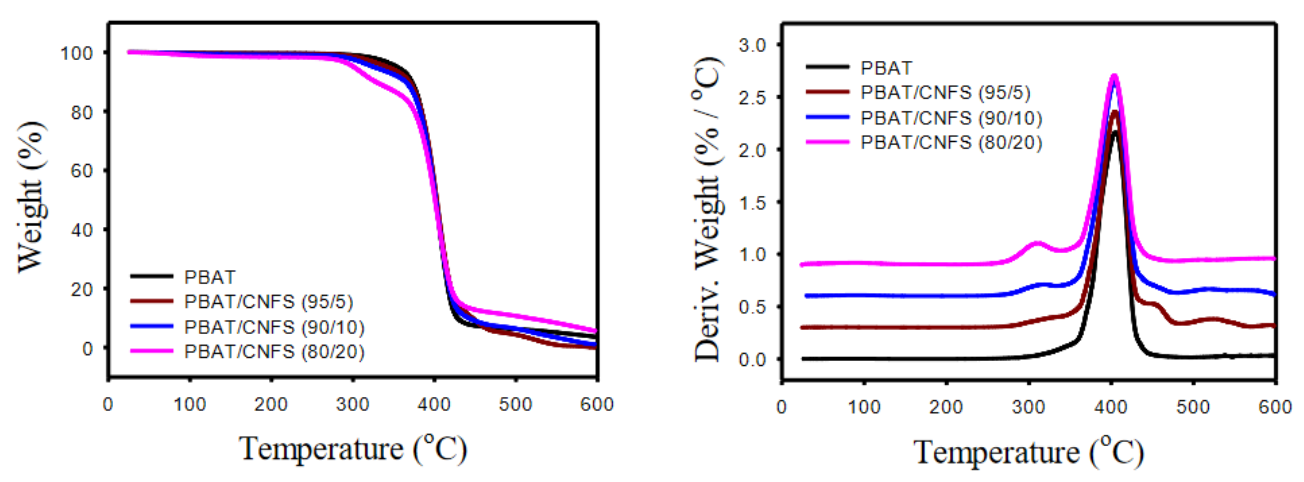
Figure 8. TGA and DTG curves of neat PBAT and PBAT/CNFs blends (with 5, 10 and 20 wt.% of CNFs), measured at the rate of 10 °C min −1 .